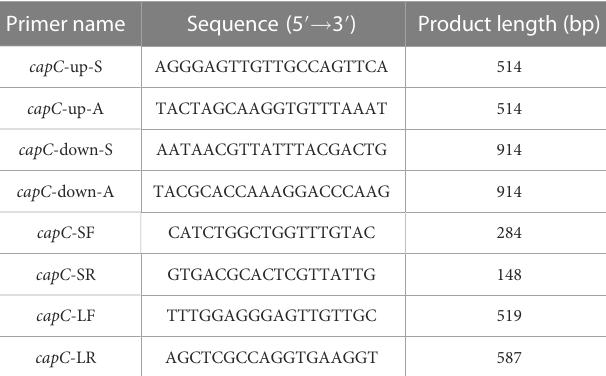
TABLE 2 Primers used to construct D capC